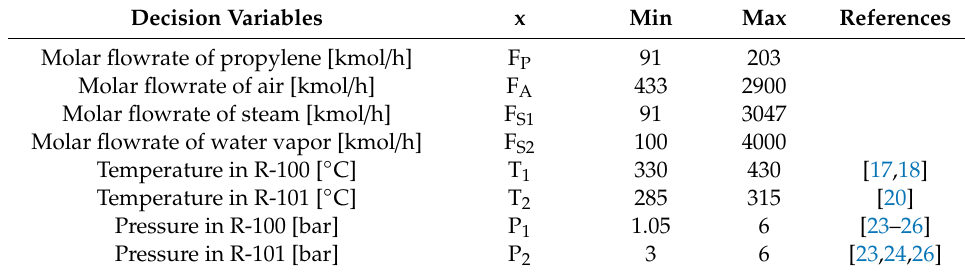
Table 2. Decision variables and their allowable